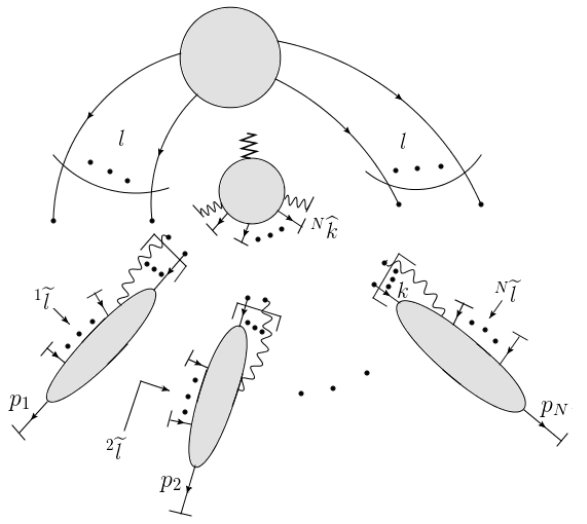
Figure 3. A pictorial representation of the approximated amplitude t (cid:27) A , where (cid:27) is shown in (cid:12)g- ure 1. The propagators with intact endpoints, denoted by dots, retain momenta before projections, while the truncated lines, denoted by bars, provide their projected momenta to the corresponding subgraphs. At each internal vertex of a bubble, the incoming and outgoing momenta are conserved.